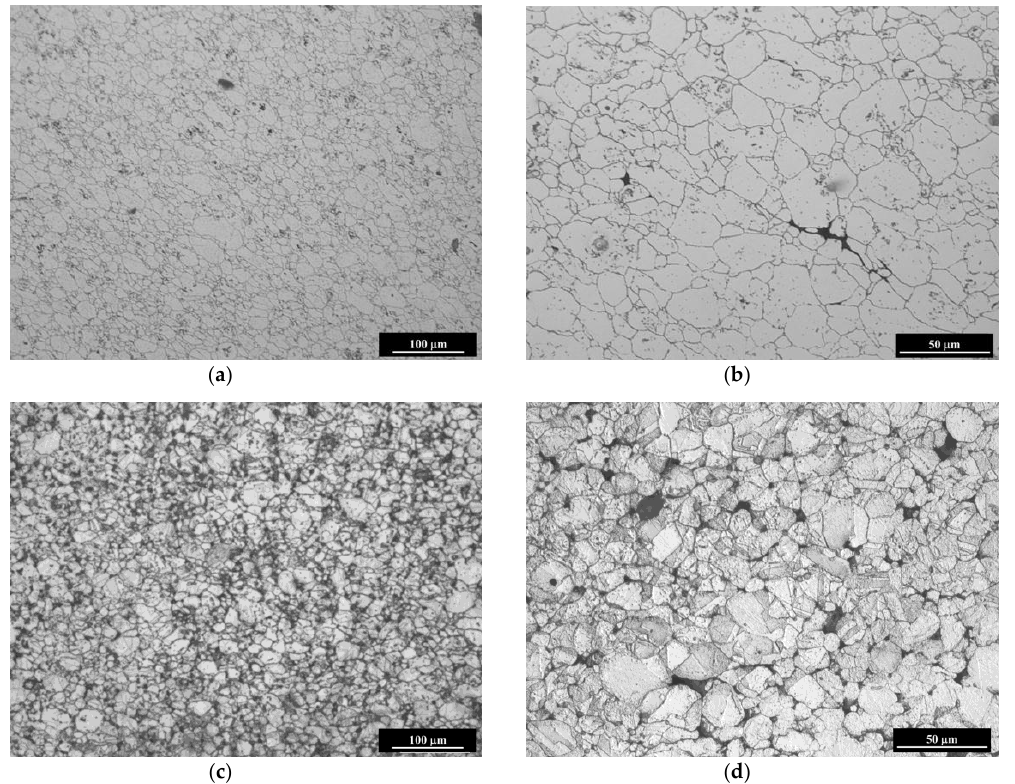
Figure 3. Optical microscopy (OM) images of the nanocomposites produced with 1.00 vol % of CNTs: ( a ) and ( b ) Al/CNTs and ( c ) and ( d ) Ni/CNTs.